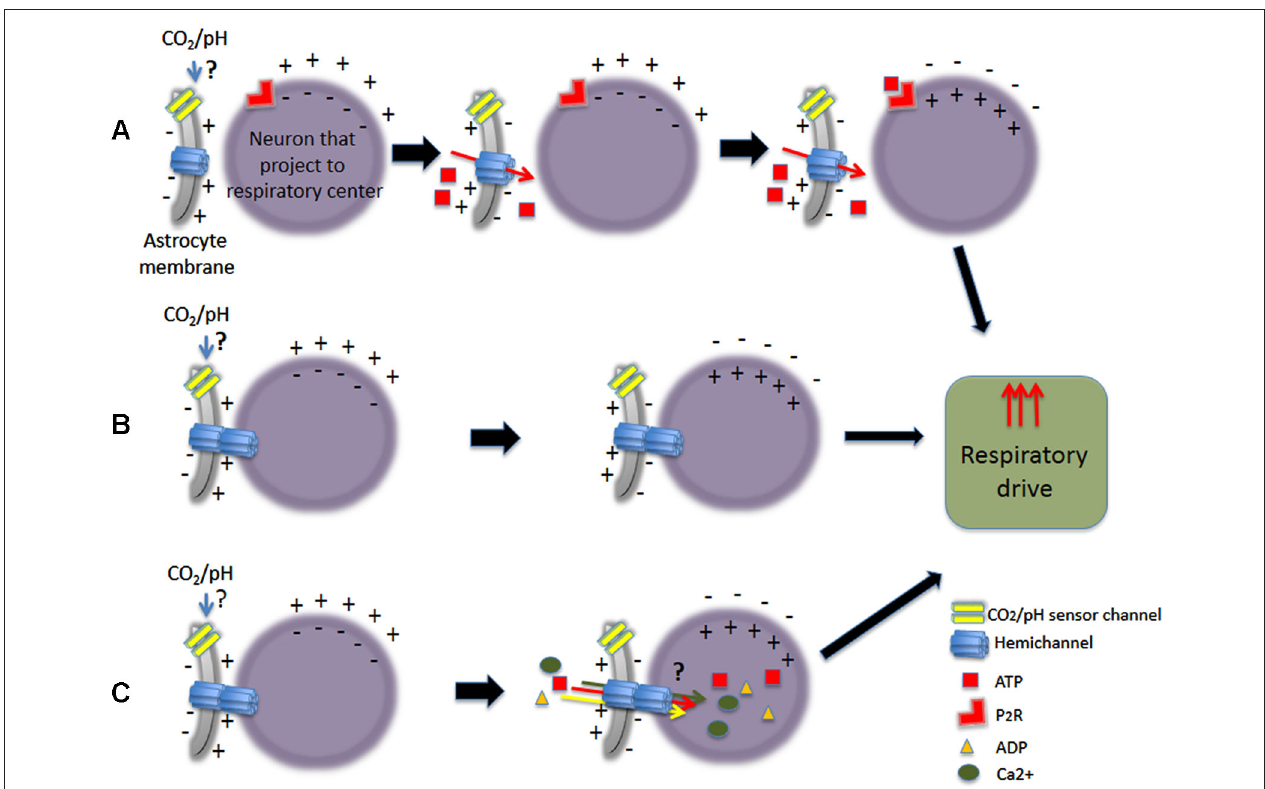
respiratory center, being either chemosensory neurons or not. (A) Chemical stimulation by ATP release. (B) Stimulation by electrical coupling. (C) Stimulation of neurons by electrical coupling with passage of small